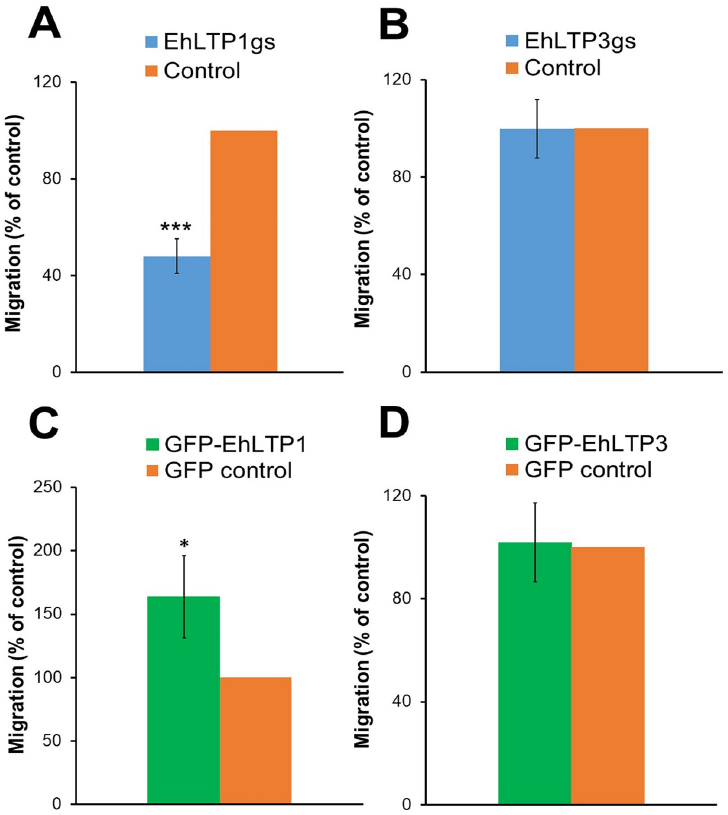
Fig 6. Effects of gene silencing of EhLTP1 (A) and EhLTP3 (B) or overexpression of EhLTP1 (C) and EhLTP3 (D) on cell motility in the transwell migration assay of E . histolytica trophozoites. Motility of E . histolytica transformants and vector control cell lines through 8 μ m pores towards either BI-S-33 medium containing bovine serum or BI medium lacking serum (as Blank or gravity control) at 37˚C was assayed as described in Methods. The percentages of the cells that migrated from upper BI medium to lower BI-S-33 medium in 12h are shown. The experiment was repeated three times independently in duplicates (N = 3 with error bars indicating standard deviation). Statistical comparisons were made by Student’s t-test ( � P � 0.05, �� P � 0.005, ��� P � 0.0005).